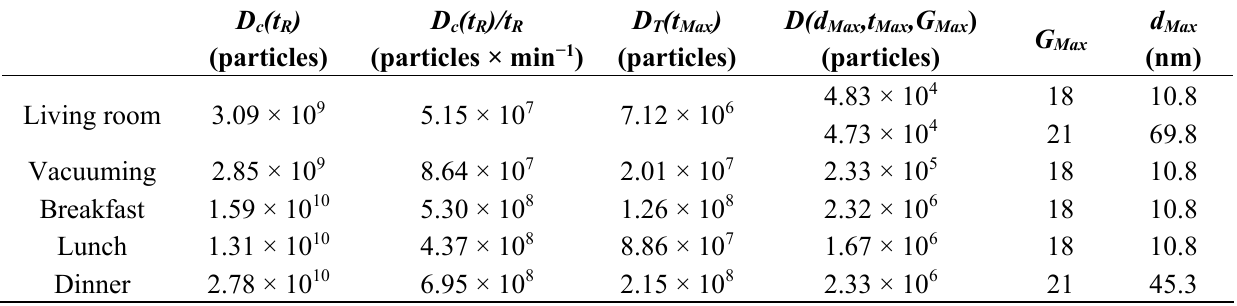
Figure 4. Living room: ( a ) total instant dose D T (t) and cumulative dose D c (t) as a function of time; ( b ) instant dose per airway generation D G (t,G) as a function of time and airway generation number; ( c ) maximum instant dose D(d,t Max ,G) at the maximum D T (t) value (the red cross in (a)) as a function of particle diameter and of airway generation number. Table 1. Cumulative doses D c (t R ) , cumulative doses per unit time D c (t R )/t R at the end of the residence time ( t R ), maximum value of the total instant dose D T (t Max ), maximum value of the instant doses D(d,t,G) at t Max and relevant value of d ( d Max ) and airway generation number G ( G Max ) in a living room and a kitchen (breakfast, lunch and